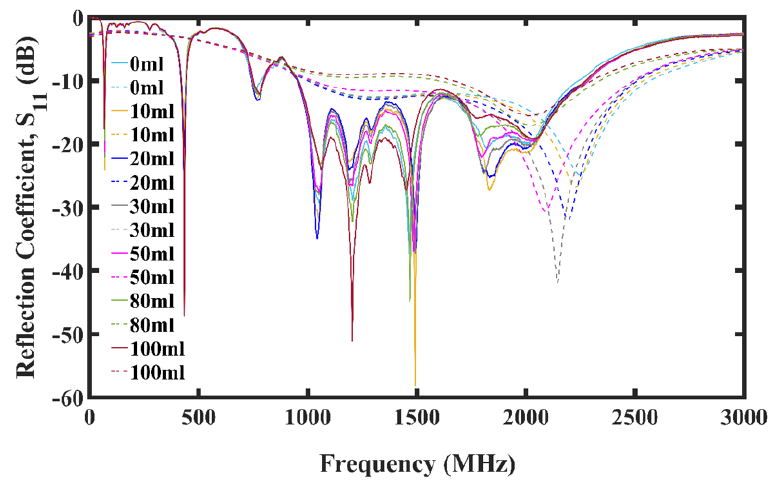
Figure 6. Plot showing reflection coefficient for oil spill using 15 mm antenna-sensors spacing.